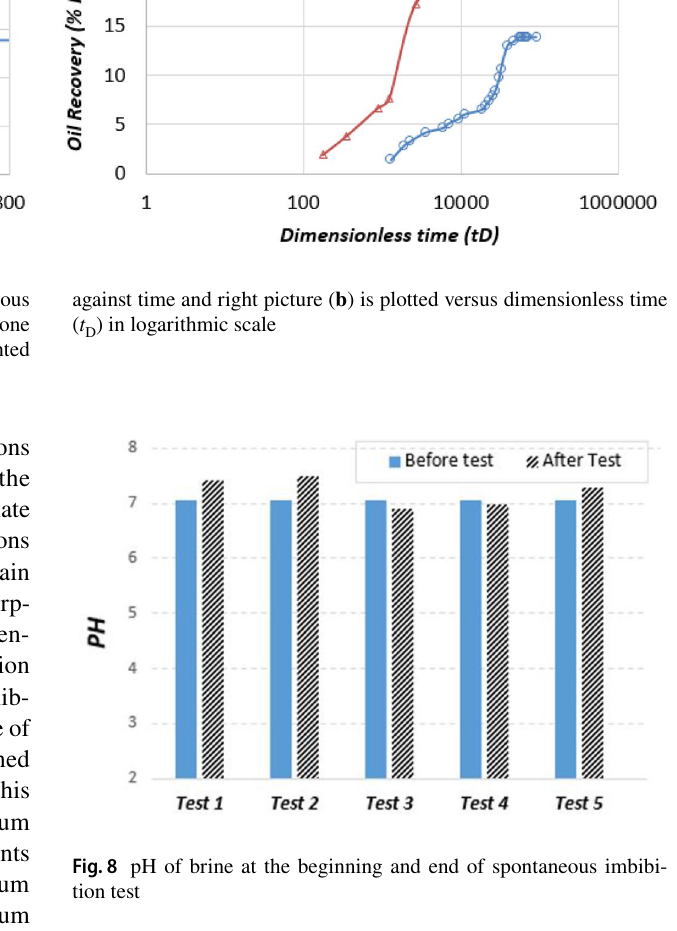
Fig. 8 pH of brine at the beginning and end of spontaneous imbibi- tion